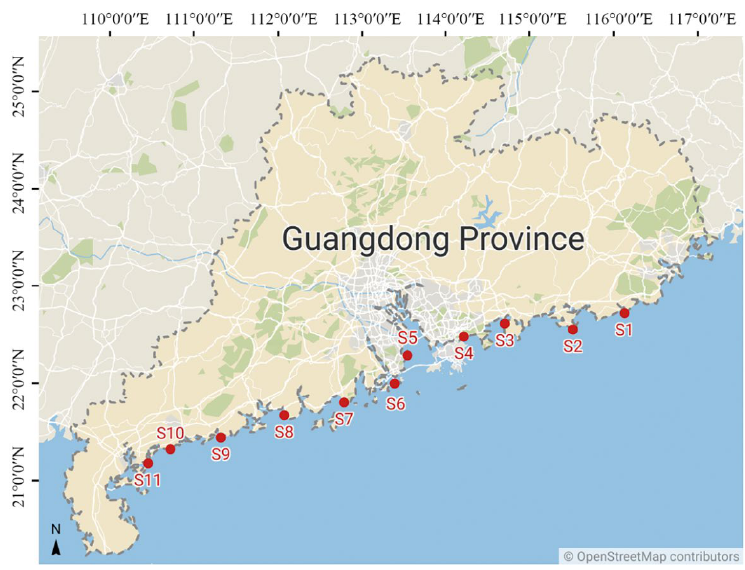
Figure 1. Location of 11 sampling sites along the Chinese coastal region.